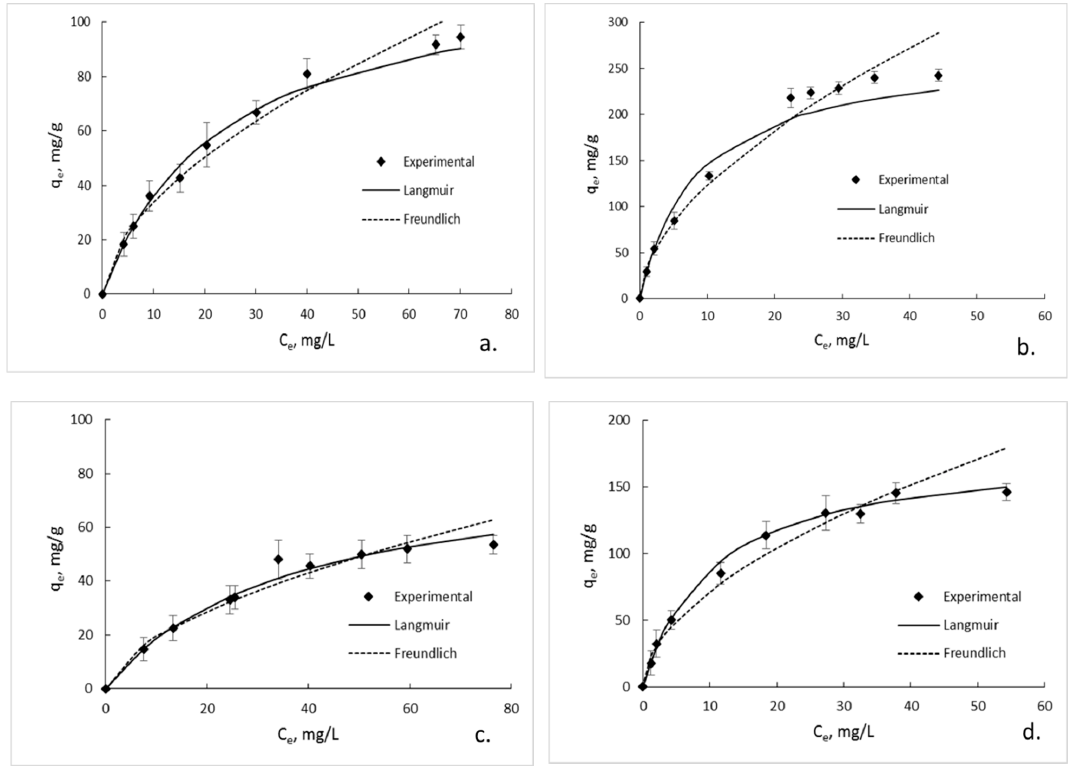
Figure 8. Sorption isotherms of Zn (II) from aqueous solutions under different pH conditions: ( a ). GG at pH 6; ( b ). GG/GO at pH 6; ( c ). GG at pH 3 and ( d ). GG/GO at pH 3. Error bars represent the calculated standard deviation for the experimental data. Table 2. Fitting parameters for Langmuir and Freundlich isotherms of Zn (II) sorbed on GG and GG/GO.